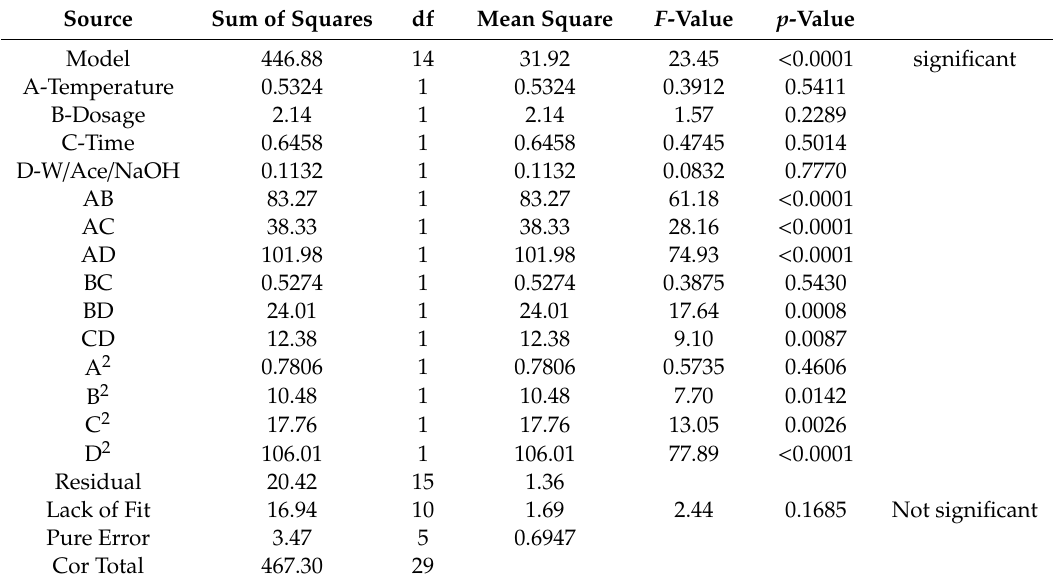
Table 5. ANOVA for quadratic